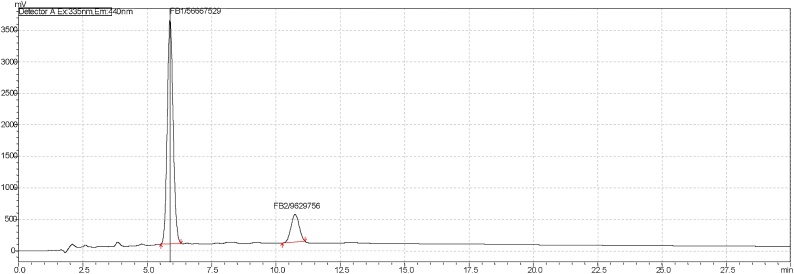
Illustration of a chromatogram of dairy cattle feed sample from the largest institutional farm at 20 ul injection on high performance liquid chromatography coupled with RF detector and KobrA cell.